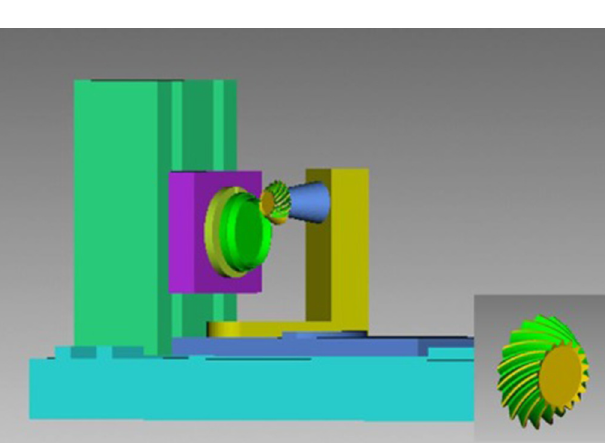
Fig. 11. Simulation process and Figure 11. A comparison between simulation product with theoretical was done and the results are shown in Figure 12.